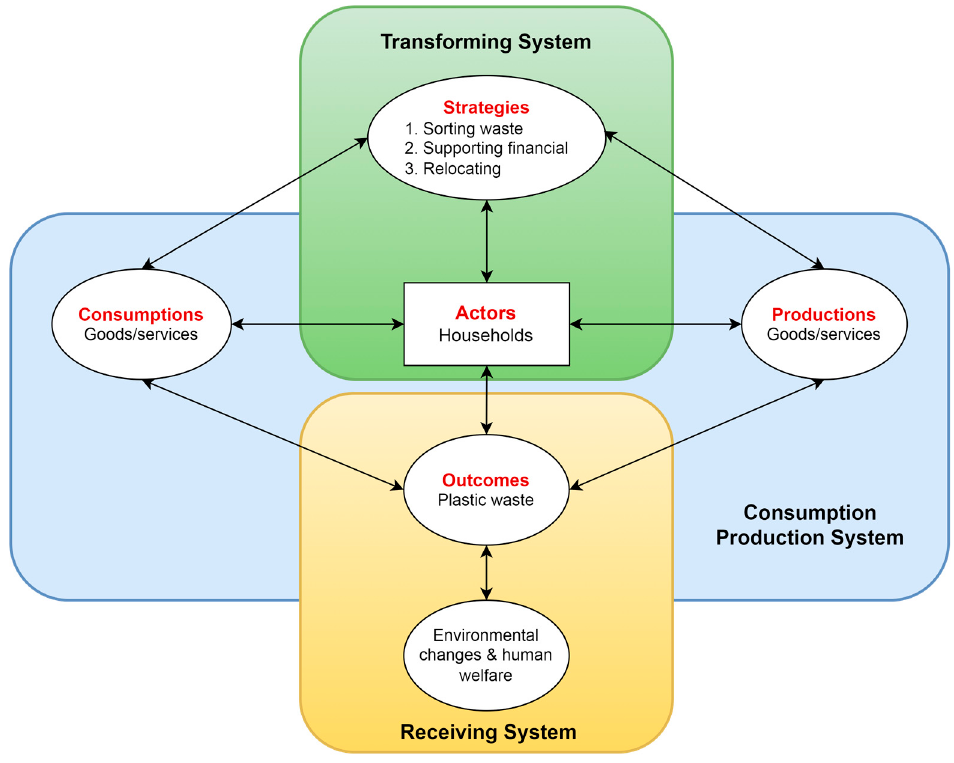
Figure 1. Framework for plastic waste treatment.